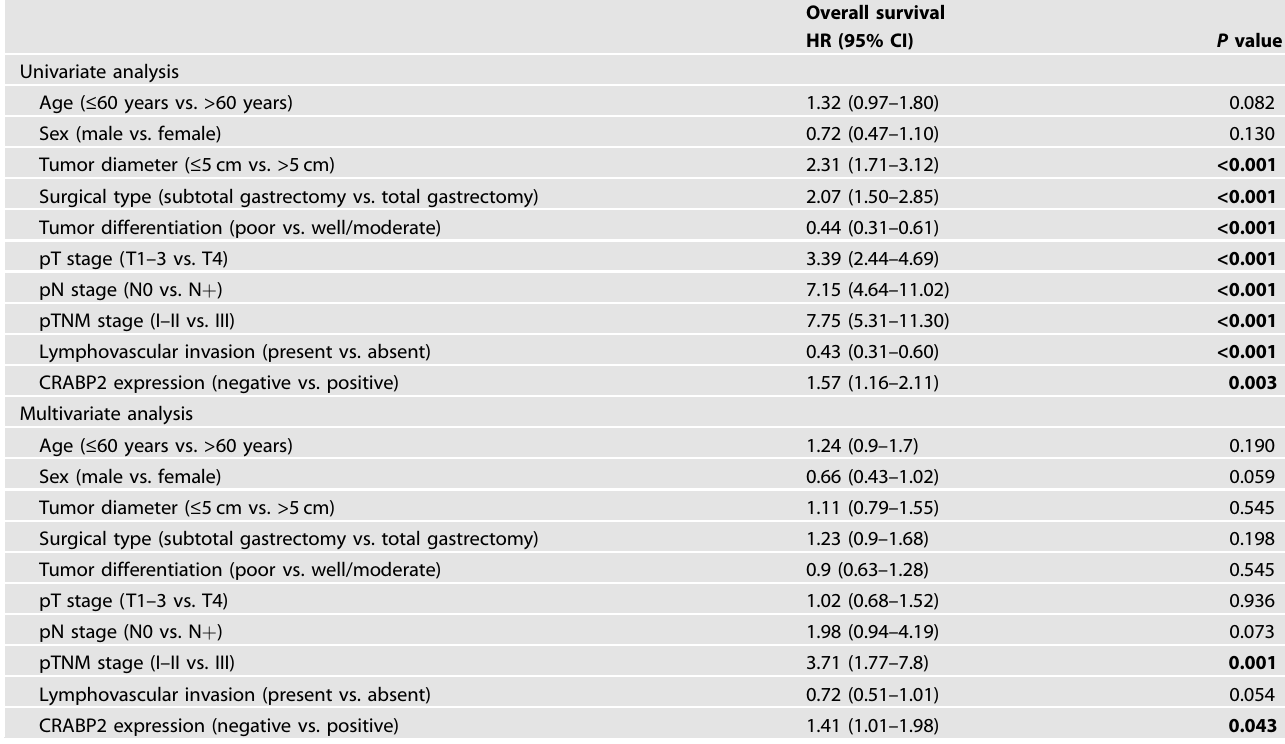
Table 2. Univariate and multivariate analysis of factors associated with overall survival in GC patients.